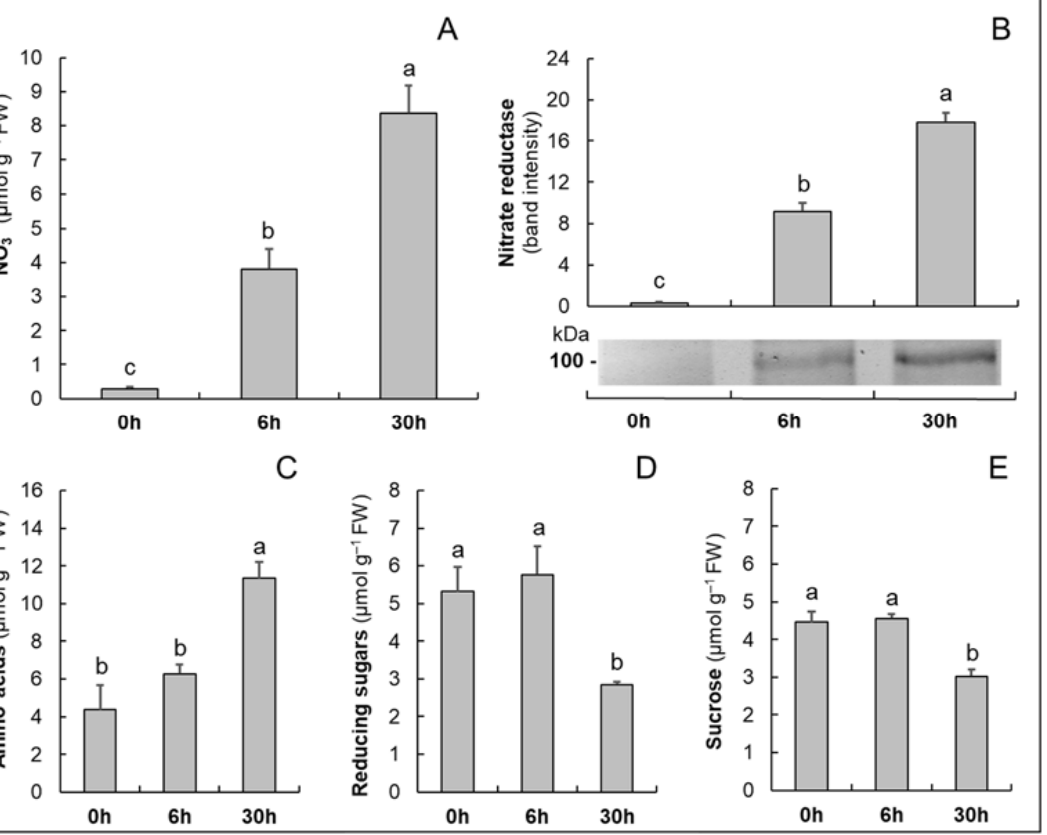
Figure 1. The time course of the changes in the contents of NO 3 − ( A ), in the accumulation of nitrate reductase evaluated by immunoblot analysis ( B ), and in the contents of amino acids ( C ), reducing sugars ( D ) and sucrose ( E ) in the roots of M4 grapevine rootstock, previously grown in the absence of N for 8 d (0 h) and incubated for a further 6 and 30 h in the presence of 10 mM NO 3 − . The values are means ± SE ( n = 3). Statistical significance was assessed by one-way ANOVA and the Holm–Šídák method. Different letters indicate significant differences ( p ≤ 0.05).